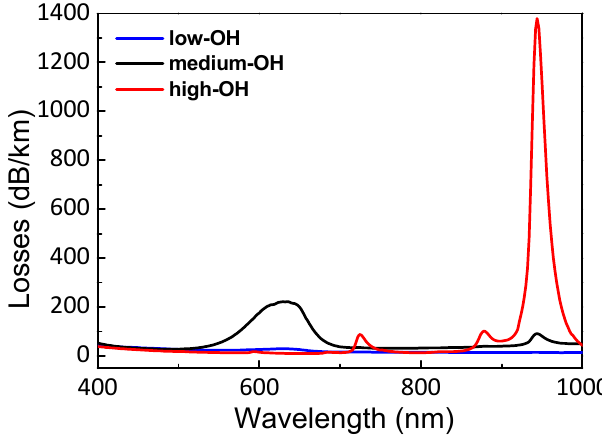
Table 1. Main characteristics of the three fibers under test.